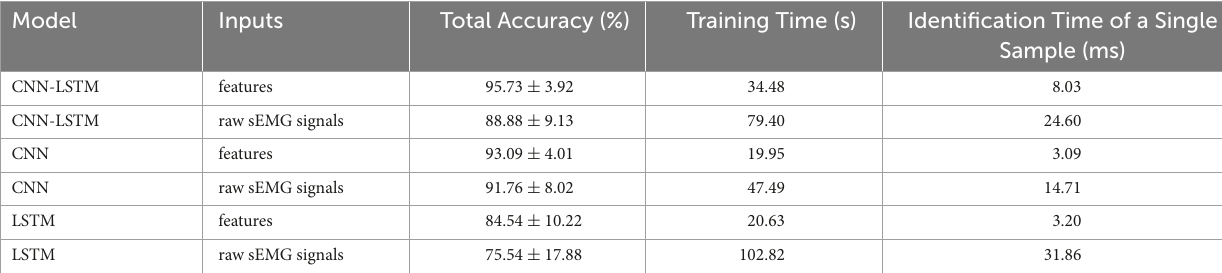
TABLE 6 Performance of different network architecture and